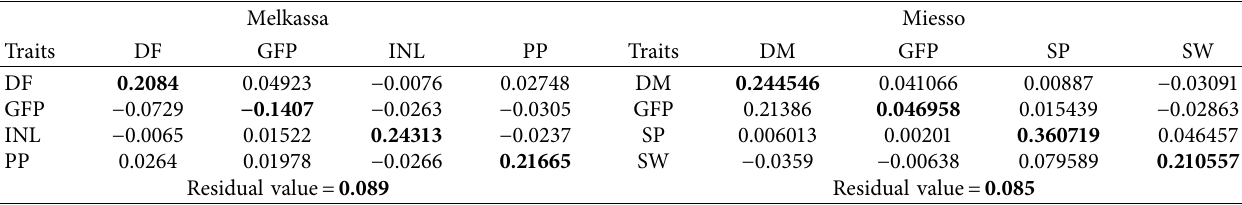
Table 8: Estimate of direct (bold diagonal) and indirect efects (of diagonal) of yield-related traits on seed yield at phenotypic level in 25 common bean genotypes tested at Melkassa and Miesso in 2018 cropping season. Melkassa